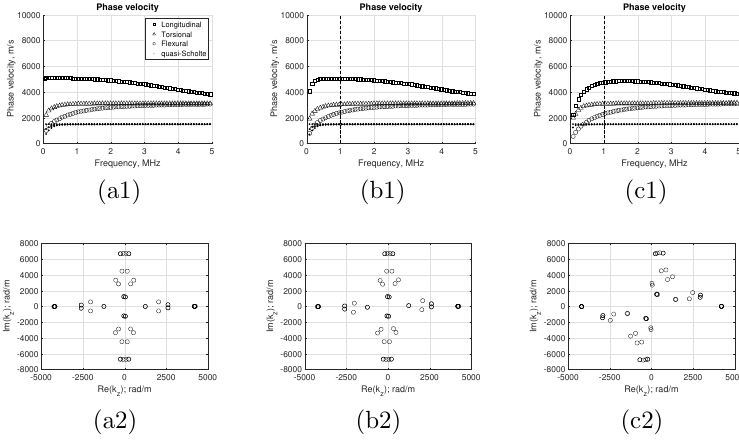
Figure 6. Phase velocity (1) and wavenumbers (2; at 1 MHz (dashed line)) of immersed waveguide with Rayleigh damping; a = 1 · 10 5 , b = 1 · 10 − 10 (a); a = 1 · 10 6 , b = 1 · 10 − 9 (b); a = 1 · 10 7 , b = 1 · 10 − 8